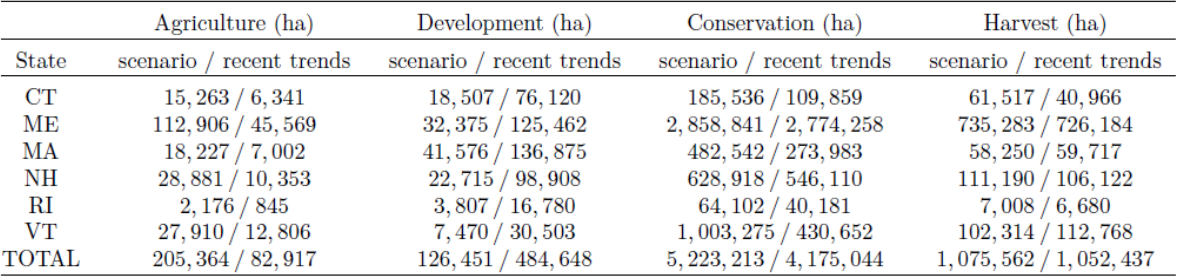
Table A3.1. New Transitions 2010-2060 (Connected